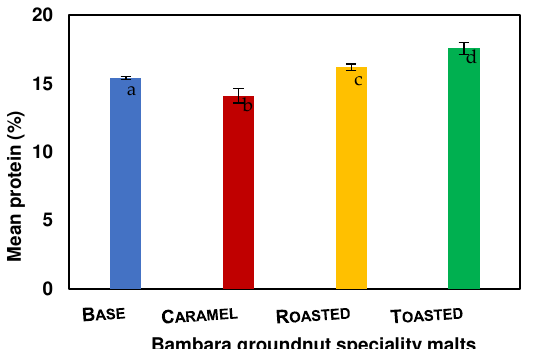
Figure 4. Protein content of Bambara groundnut speciality malts. Values are the mean of triplicates ± standard deviation; mean values on the bars with different letters are significantly different ( p < 0.05).